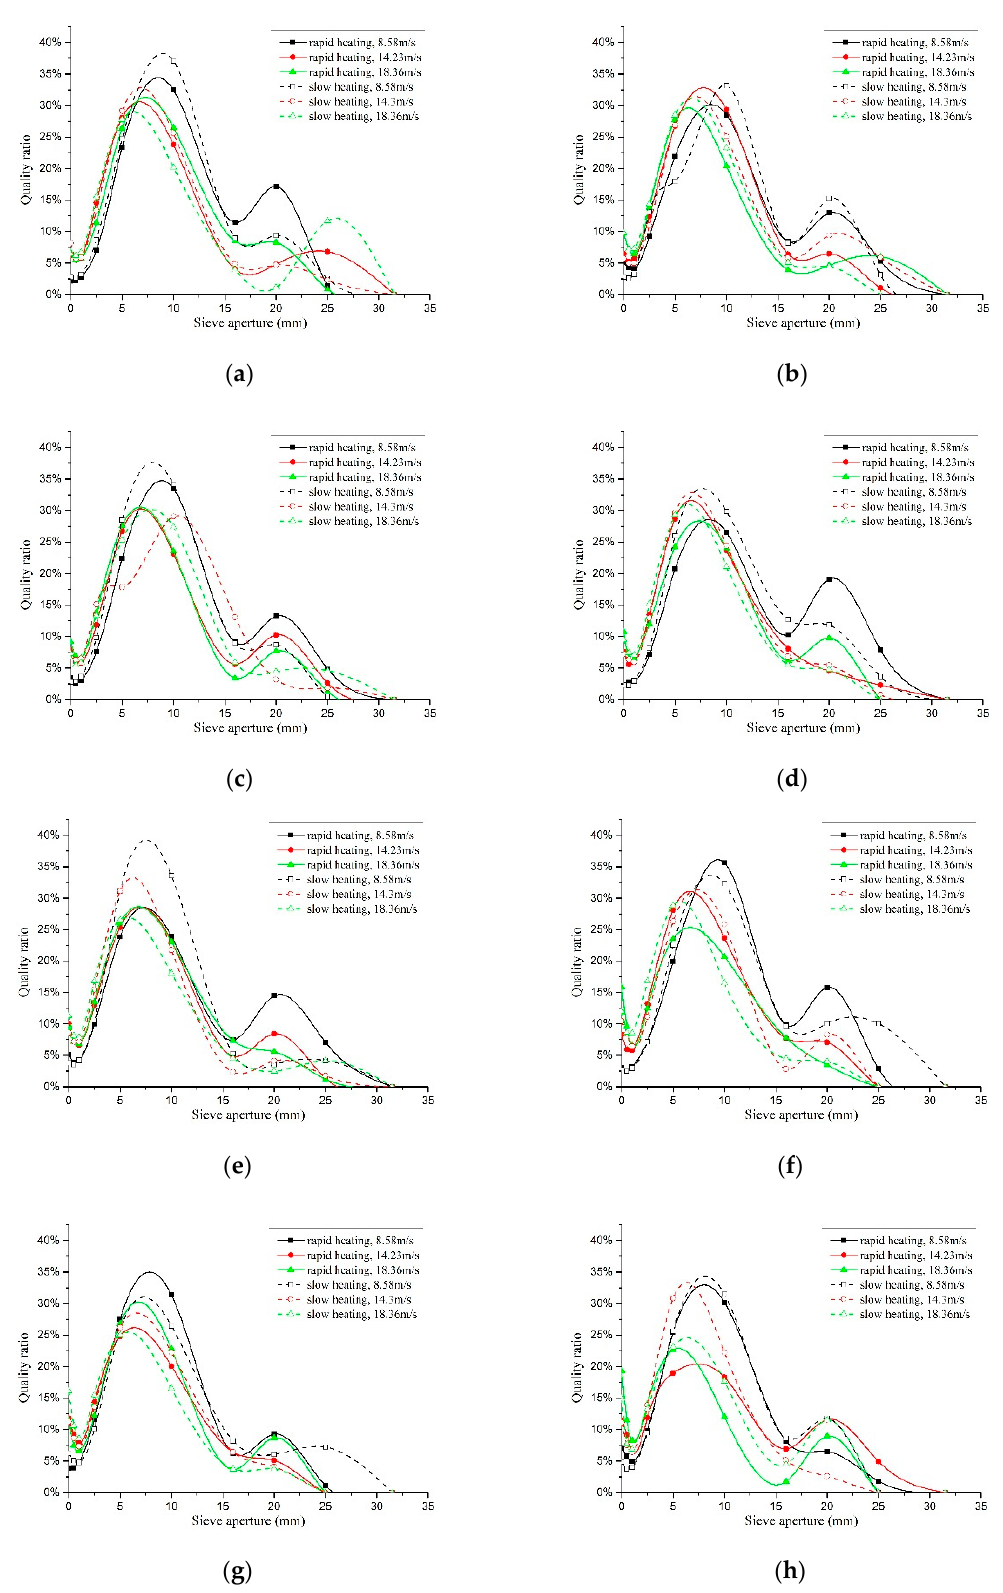
Figure 14 . Sieve pore size-mass of the retained on sieve curve under different temperatures. ( a )